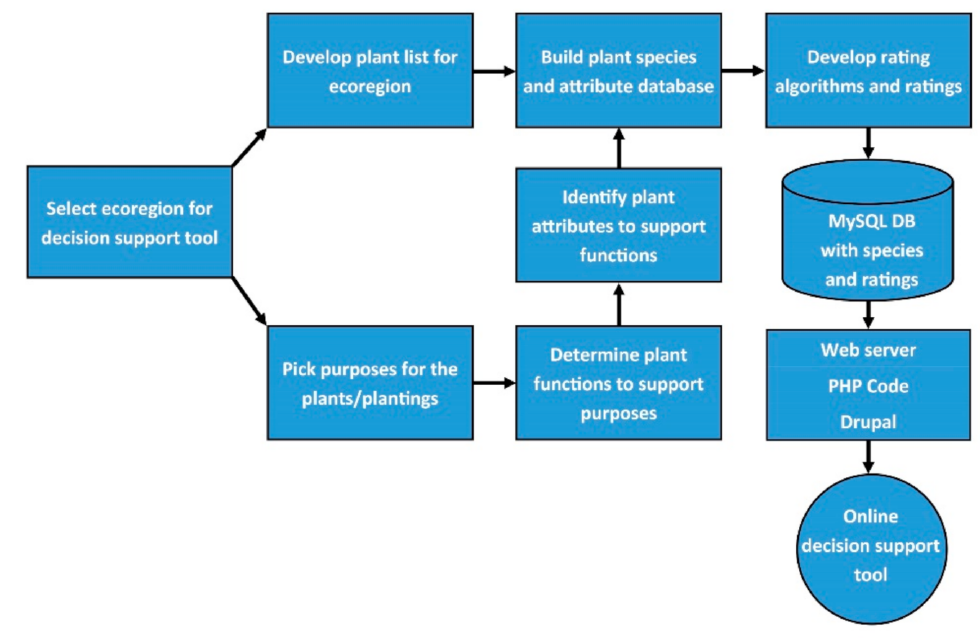
Figure 1. Framework used to develop the decision support tool called Tree